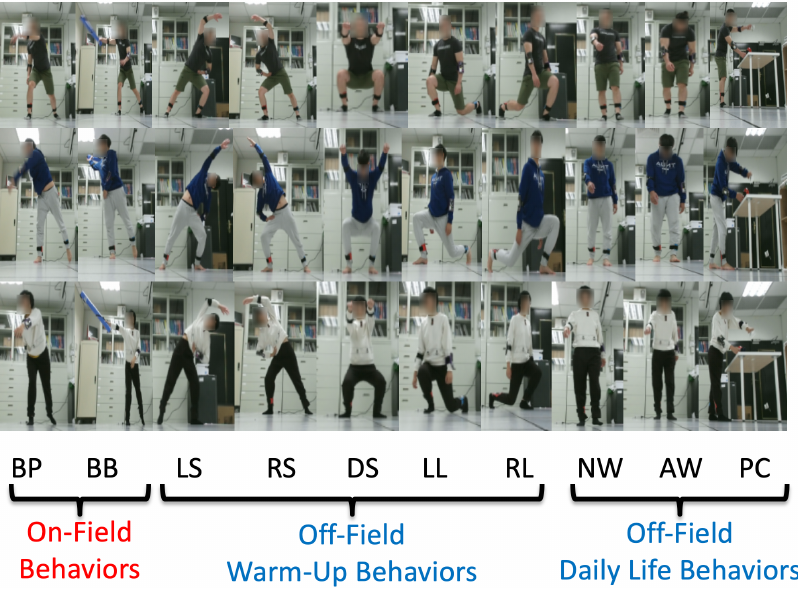
Figure 11. Ten on- and off-field behaviors performed by users: baseball pitch (BP), baseball bat (BB), left stretch (LS), right stretch (RS), deep squat (DS), left lunge (LL), right lunge (RL), normal walking (NW), abnormal walking (AW), and coffee pouring